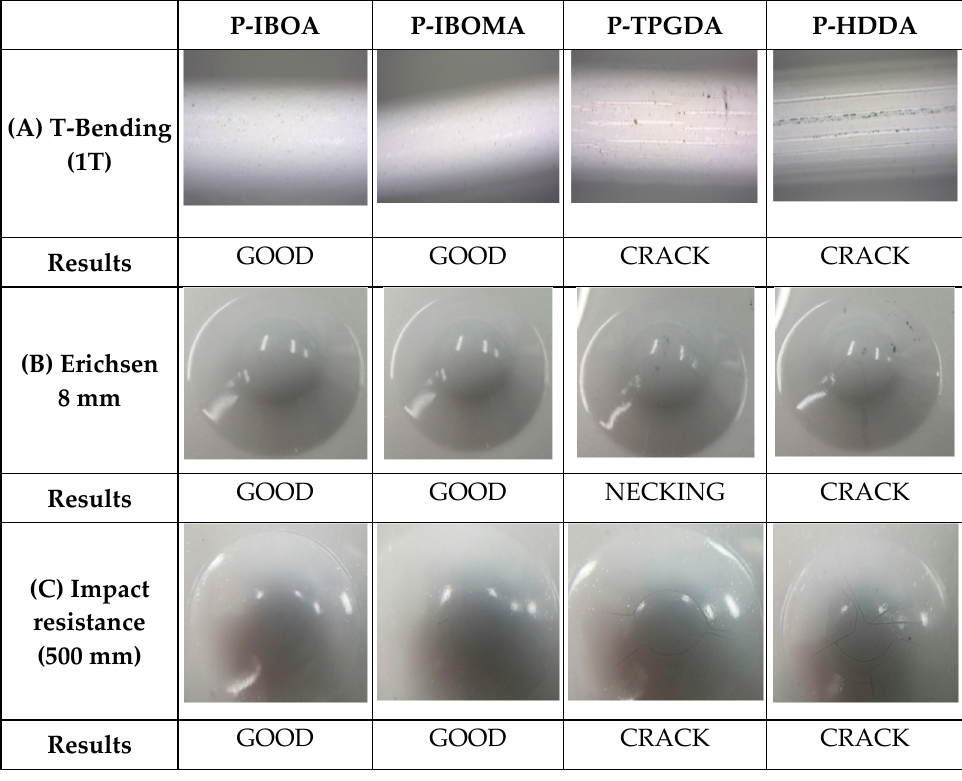
Figure 9. ( A ) 1T T-bending, ( B ) Erichsen (8 mm), and ( C ) impact resistance (500 mm) test images of UV-cured PUA coating films.